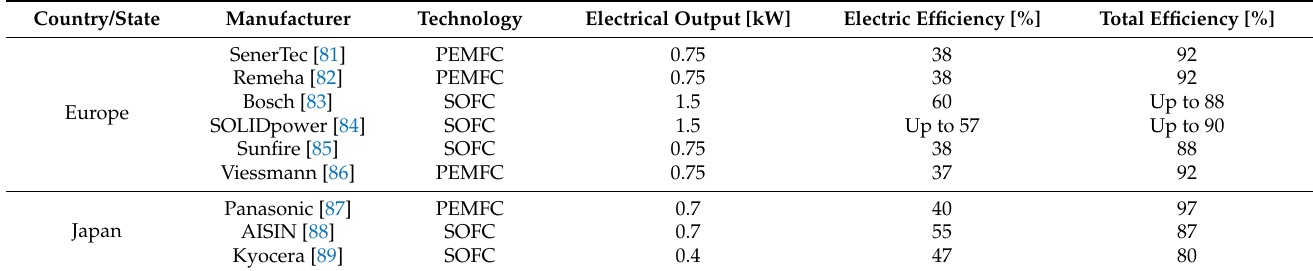
Table 2. PEMFC and SOFC, micro-CHP